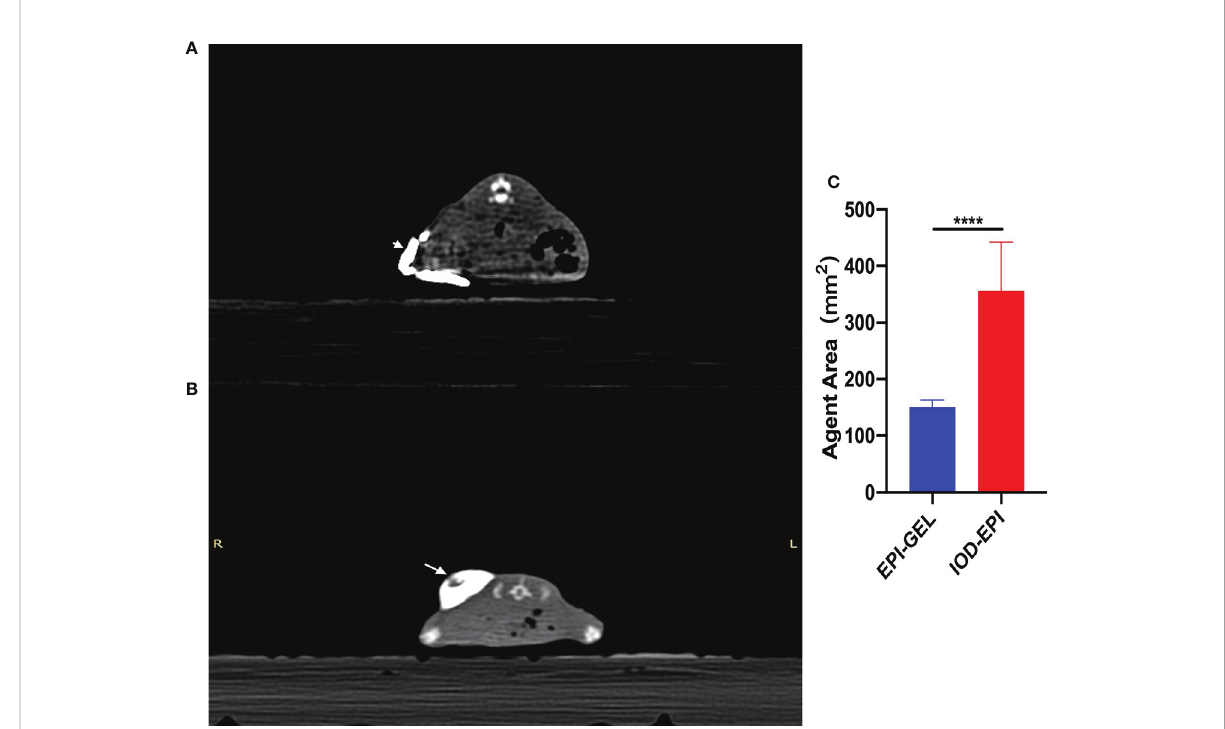
FIGURE 4 (A, B) Immediate post-injection CT scans showing the distribution of 400 m l epirubicin (EPI) with iodized oil as carrier ( arrowhead ) (A) and with polyethylene glycol (PEG) hydrogel as carrier ( arrow ) (B) . (C) The drug dispersion area (product of the maximum length and the short diameter) of the IOD-EPI (EPI powder mixed with iodinated oil) group immediately after injection was signi fi cantly larger than that of the EPI-GEL (single injection of EPI gel) group. **** p < 0.0001 (Student ’ s t